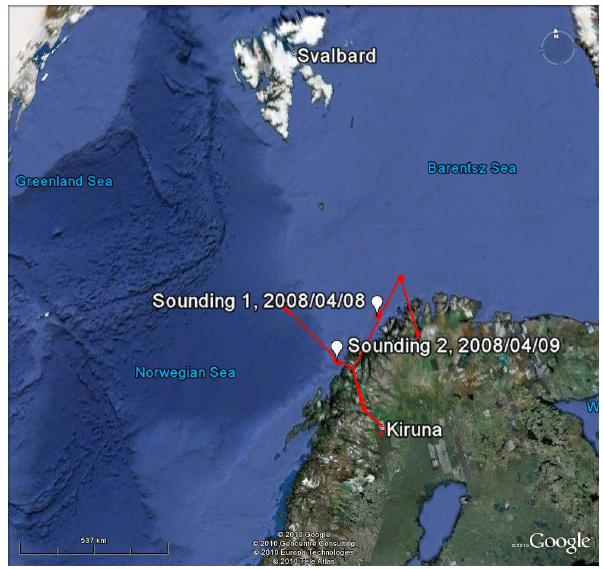
Fig.2. Tracksoftheflightsas0831(8April2008)andas0833(9April2008)ofthePOLARCAT-FRANCESpringcampaign. Twosoundings are studied in this work, respectively at 71 ◦ N, 22 ◦ E and 70 ◦ N, 17.8 ◦ E. Fig. 2. Tracks of the flights as0831 (8 April 2008) and as0833